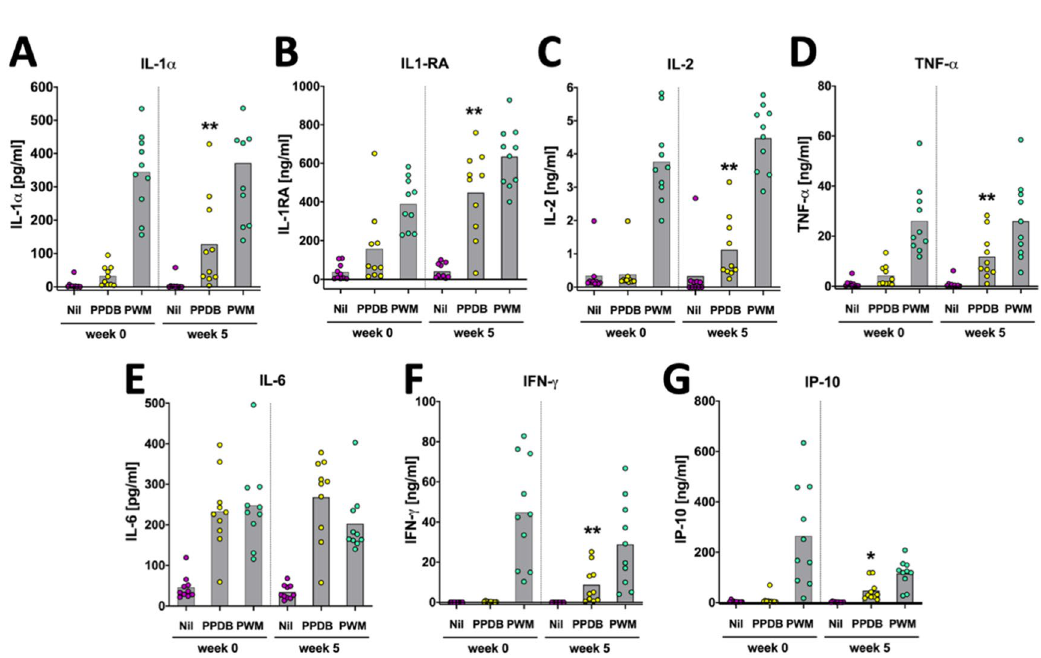
Figure 3. Cytokine and chemokine profiles in whole blood cultures of BCG vaccinated calves before and 5 weeks post-vaccination. Whole blood samples were collected at weeks 0 and 5 post-BCG vaccination and stimulated with PPD-B, PWM or left unstimulated. Cytokine and chemokine profiles were determined using a Luminex-based multiplex array. Each dot represents responses of individual animals with bars indicating mean responses. Statistical analysis: Paired two-tailed t-test: *, P < 0.05; **, P < 0.005; compared to week in the PPD-B stimulated blood responses, with the exception of TNF-α which was not detected in ISF obtained from SMNs.